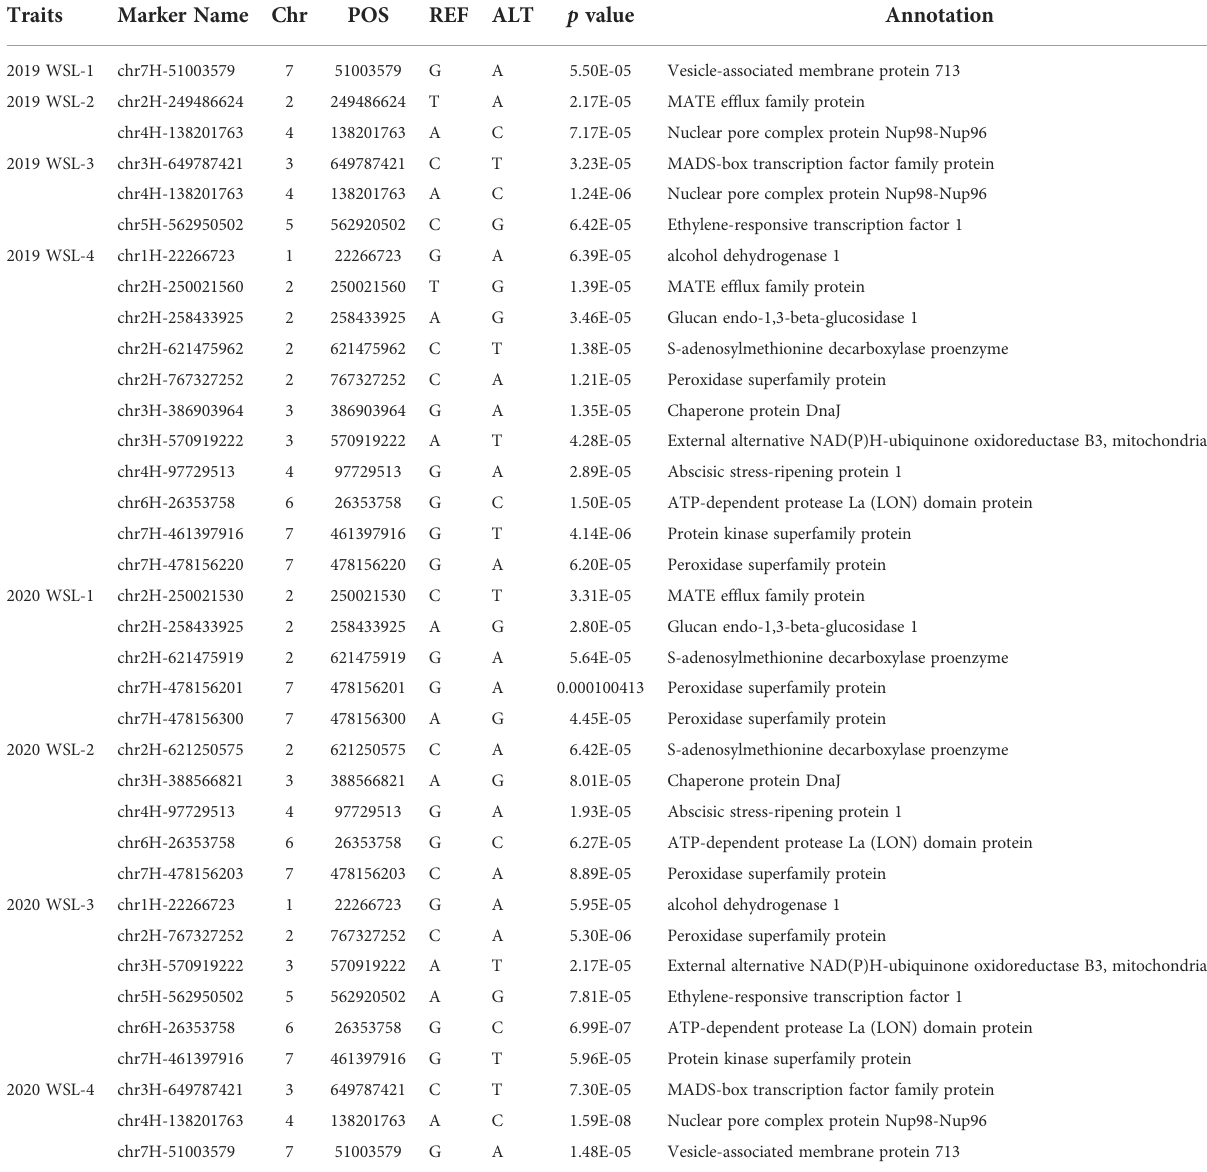
TABLE 3 Signi fi cant SNPs associated with waterlogging identi fi ed across two or more environments.